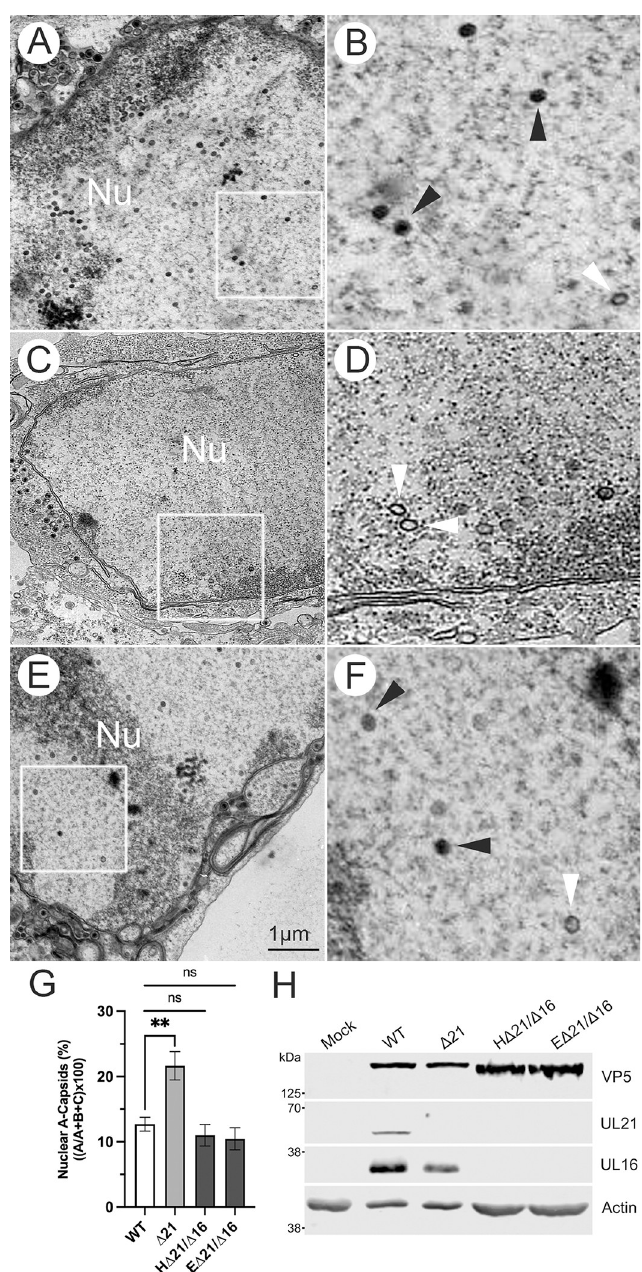
Fig 7. Characterization of capsids produced by Δ 21/ Δ 16 double mutants. A-F) Vero cells were infected with either HSV-1 KOS WT ( A and B ), Δ 21 ( C and D ), or E Δ 21/ Δ 16 strains ( E and F ) at an MOI of 3 for 18 hpi and examined by TEM. The 1 μ m scale bar applies to panels A , C , and E . White arrowheads indicate nuclear A-capsids and panels B , D , and F are three-fold magnified images of panels A , C , and E , respectively. G ) Quantification of nuclear A-capsids in cells infected with the indicated HSV-1 KOS derived strains (n = 11–14 micrographs per condition). WT and Δ 21 data used for this analysis are the same as those included in Fig 1G. A one-way ANOVA with Tukey’s HSD Test for multiple comparisons were performed between all viruses. �� p � 0.01. The difference in the percentage of nuclear A-capsid was not significant when comparing H Δ 21/ Δ 16 (p = 0.886) and E Δ 21/ Δ 16 (p = 0.781) mutants to WT. H) Western blot analysis of lysates prepared from Vero cells infected with the indicated strains at an MOI of 3 at 18 hpi. Antisera used are indicated on the right side of each panel. The migration position of molecular weight markers (kDa) are indicated on the left side of each